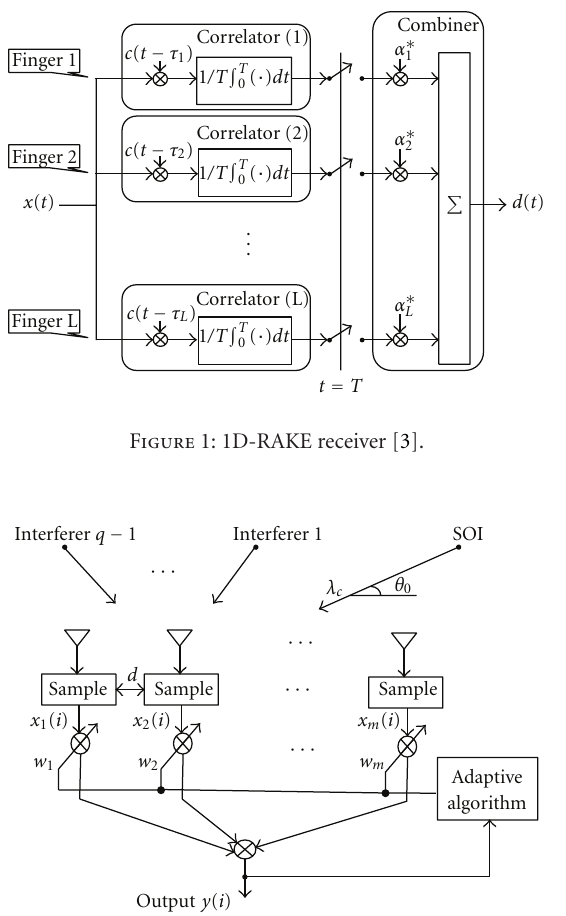
Figure 2: Adaptive beamforming